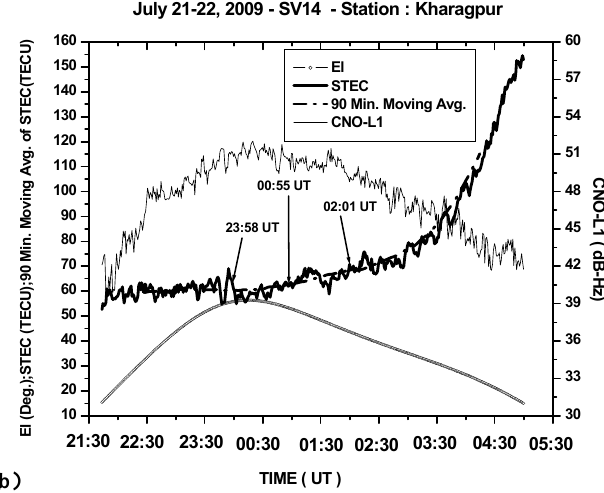
Fig. 6. The track of GPS SV14 on 22 July 2009 from 21:30 to 05:00UT is shown in (a) and the corresponding variation of slant TEC (STEC) along its track is shown in (b) . The elevation angles of the satellite, 90-min moving averages of STEC and carrier-to- noise ratios at GPS L1 frequency (CNO-L1) are also plotted in (b) .